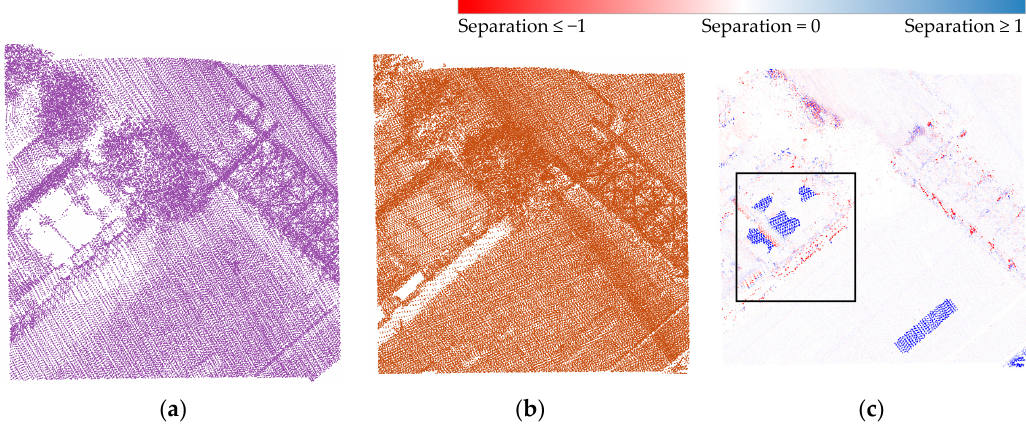
Figure 2. ( a , b ): Different colors represent different epochs of data, ( a ) 2008, ( b ) 2010; ( c ) Surface difference map derived from the two epochs. Points with a great difference do not always denote a change. For example, in ( c ) blue points in the rectangle are unknown points because there is no data for the roof in thr 2008 epoch data (perhaps caused by water on the roof), although they have high difference values.